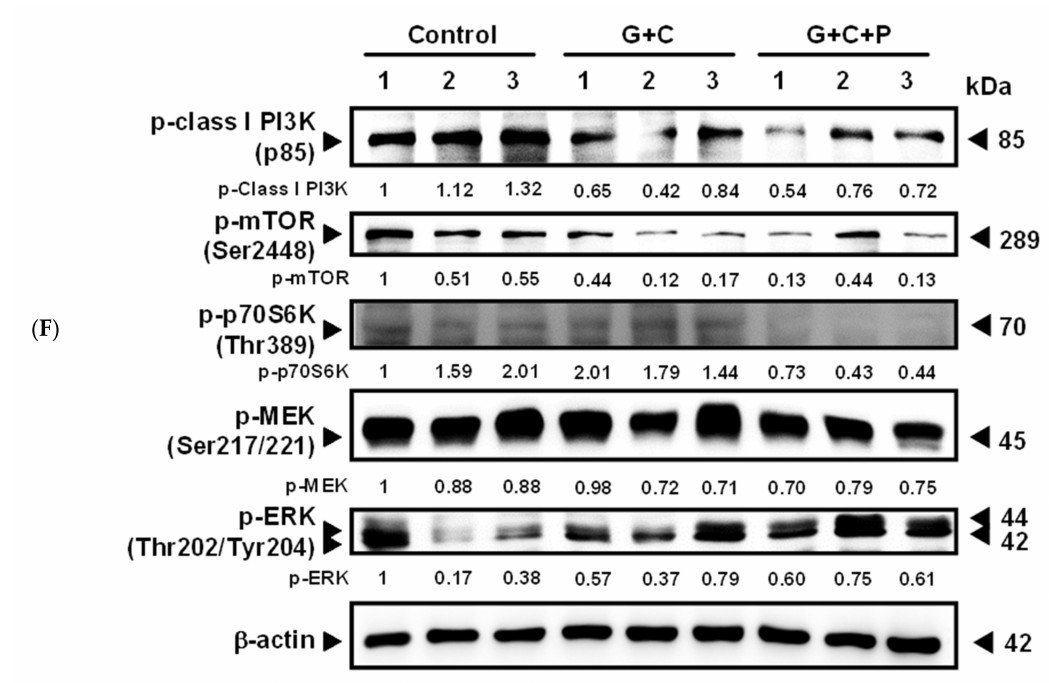
Figure 6. Cotreatment of pterostilbene significantly reduced tumorigenesis of T24 cells in mice. ( A ) Representative bioluminescence images of T24-Luc tumor-bearing mice on day 21 indicated the growth of tumor in the control group, cisplatin plus gemcitabine (C + G) group, and combination of cisplatin, gemcitabine, and pterostilbene (C + G + P) group by the IVIS imaging system. ( B ) Tumor volume was measured at the indicated time points. ( C ) Three representative bladder tumors on Day 21 are shown in the photographs. ( D ) The weights of the three representative bladder tumors were measured on Day 21. ( E ) The plasma biochemical parameters of mice at the end of the treatment. All samples were compared to control to evaluate the p -value. Data are presented as means ± SEMs. ( n = 4 each group). * denotes p < 0.05, ** denotes p < 0.01. ( F ) Protein expression in tumors. The intensity of each protein expression band was quantified through densitometry normalization to that of β -actin, with the control level arbitrarily set to 1. C denotes cisplatin; G denotes gemcitabine; P denotes pterostilbene.